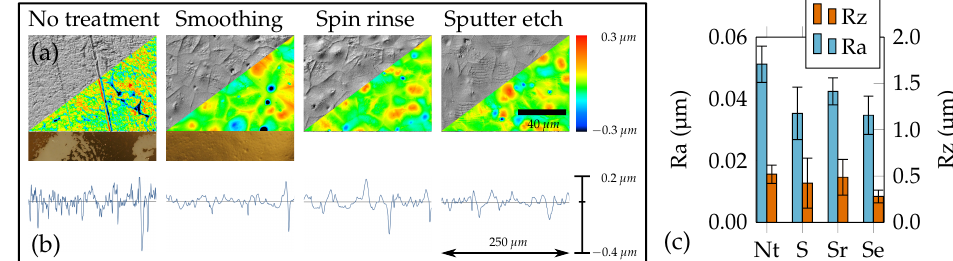
Figure 9. PVDF surface as obtained with various substrate pretreatments. ( a ) Four CLSM images, upper left triangle: Differential interference contrast images, lower right triangle: topography scans. The two supplementary images under “no treatment” and “smoothing” show tape peeling tests of a substrate coated with gold. ( b ) Roughness line scans (with identical scaling). ( c ) Effect of the surface treatments steps on roughness parameters “Ra” and “Rz” with standard deviation.